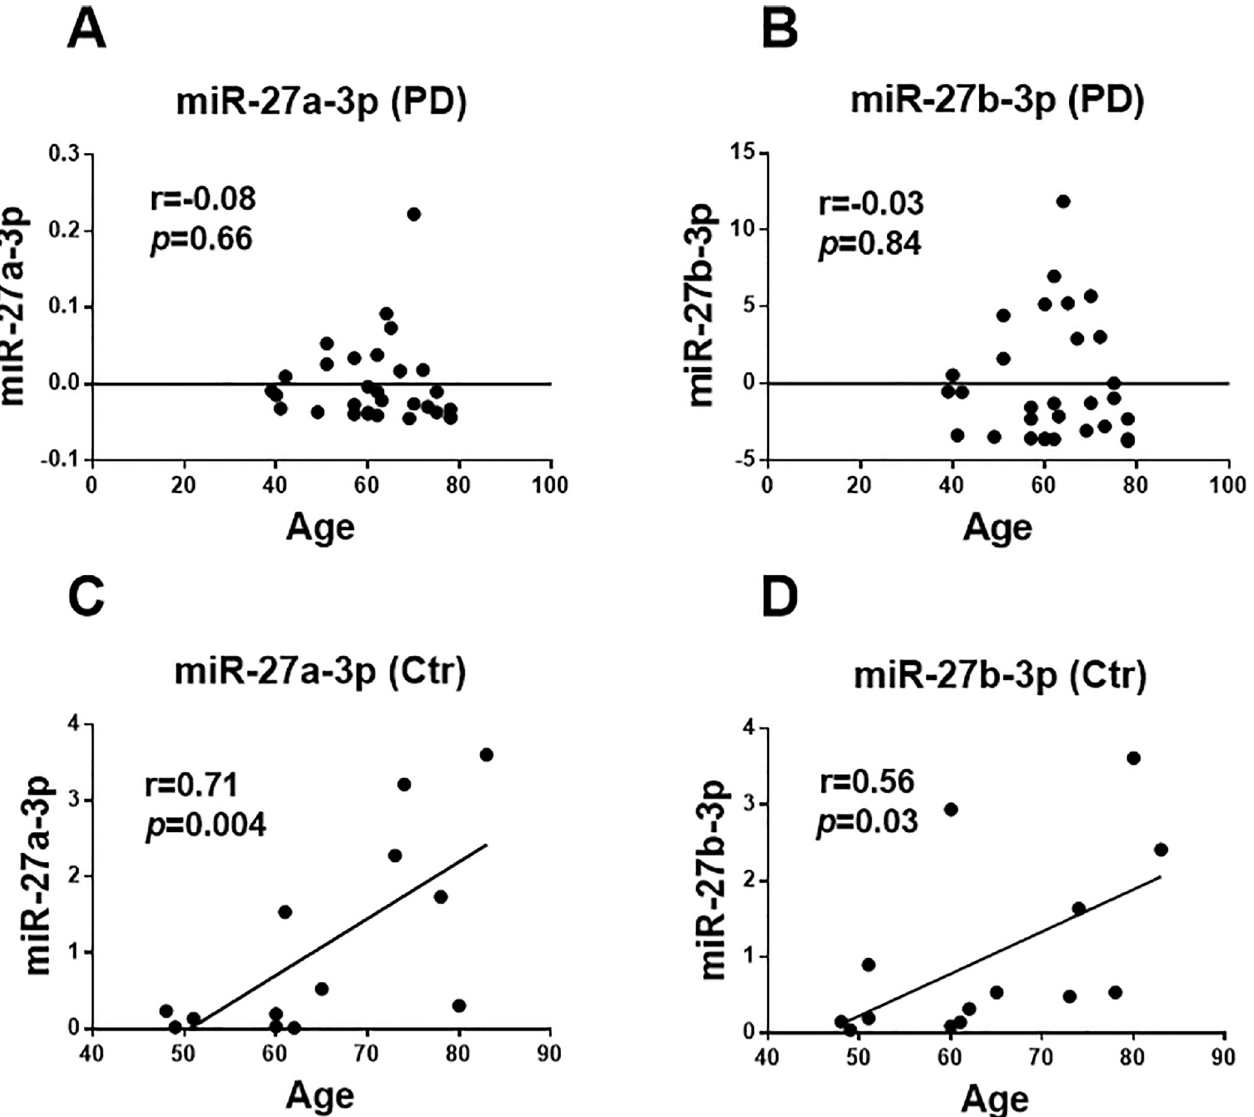
Fig 4. Association of miR-27a/b-3p levels with age factor. There are no relationships between expression of (A) miR-27a-3p and (B) miR-27b-3p with age of PD patients. Conversely, a direct significant relationship was observed in healthy subjects (C) for miR-27a-3p and (D) for miR-27b-3p association with age. Data were analyzed by Pearson’s correlation coefficient r and linear regression, with p -values are shown in the graphs. Ctr = Control; PD = Parkinson’s disease patients.